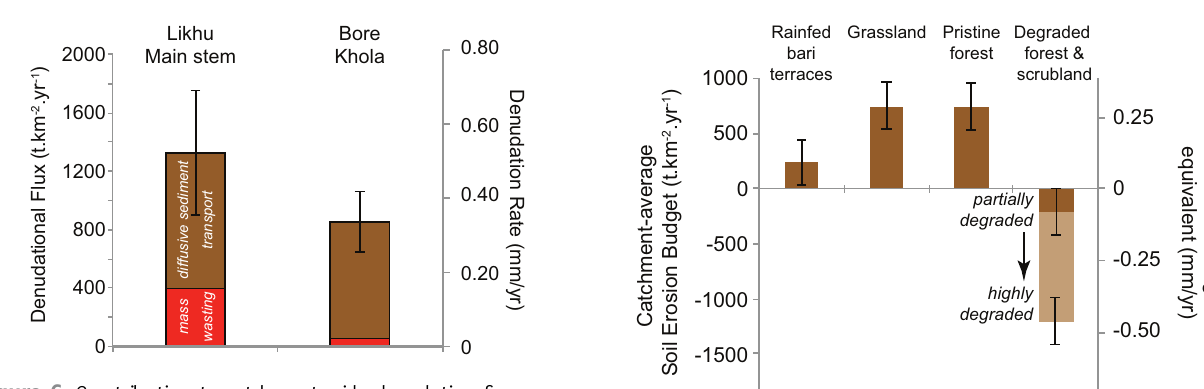
Figure 6. Contribution to catchment-wide denudation from mass wasting (determined from present-day measurements) and incre- mental sediment transport via diffusive-type processes (inferred as difference between mass wasting and total measured denudation rates; see text). Assuming present-day catchment-wide mass wast- ing fluxes represent the long-term average, then fluxes of diffusive sediment transport are similar for the Likhu main catchment and the Bore subcatchment. The diffusive fluxes provide a minimum estimate for soil production rates (see Sect. 5.4). Note that this par- titioning yields a value for catchment-averaged soil production, and does not capture significant heterogeneity in soil production rates from one soil site to another within each catchment.